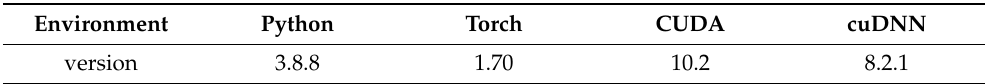
Table 2. Version parameters of the